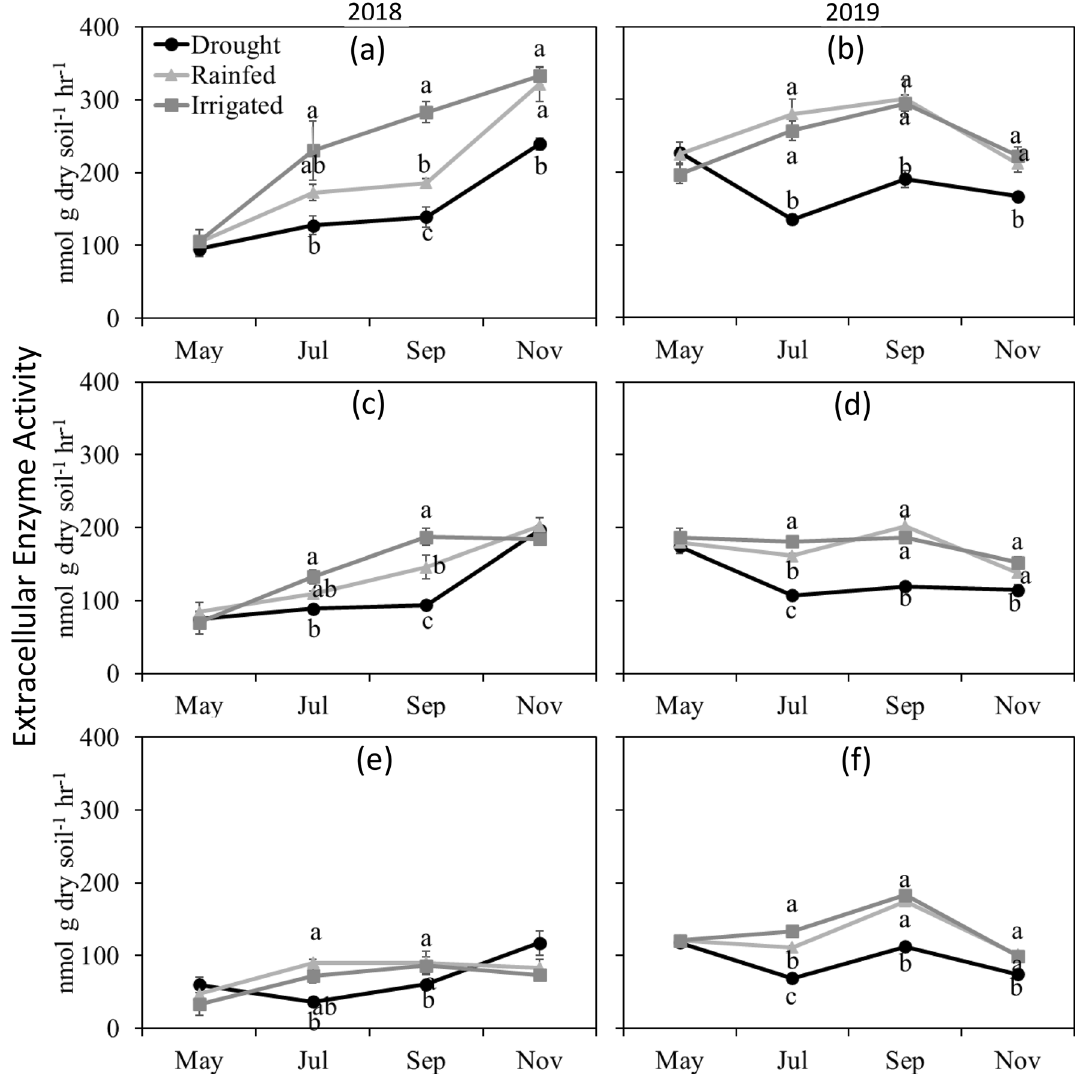
Figure 6. Total extracellular hydrolytic enzyme activity under drought, rainfed, and irrigated treatments at 0–5 ( a , b ), 5–15 ( c , d ) and 15–30 ( e , f ) cm depths during 2018 and 2019. Different letters represent statistical significance at p ≤ 0.05 at each time point. No letters mean no statistical significance. Error bars represent standard error (n = 3). Sampling in May represents baseline and in November represents post shelter